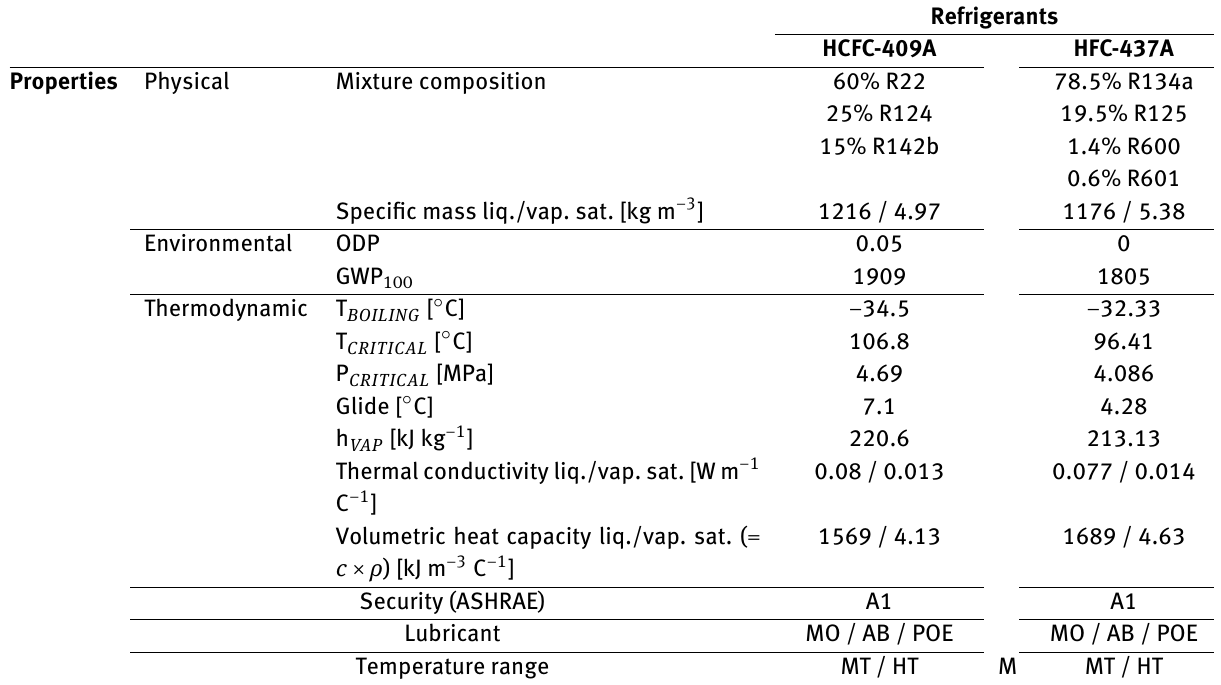
Table 3: Comparison of the characteristics of the refrigerants under study (at NTP